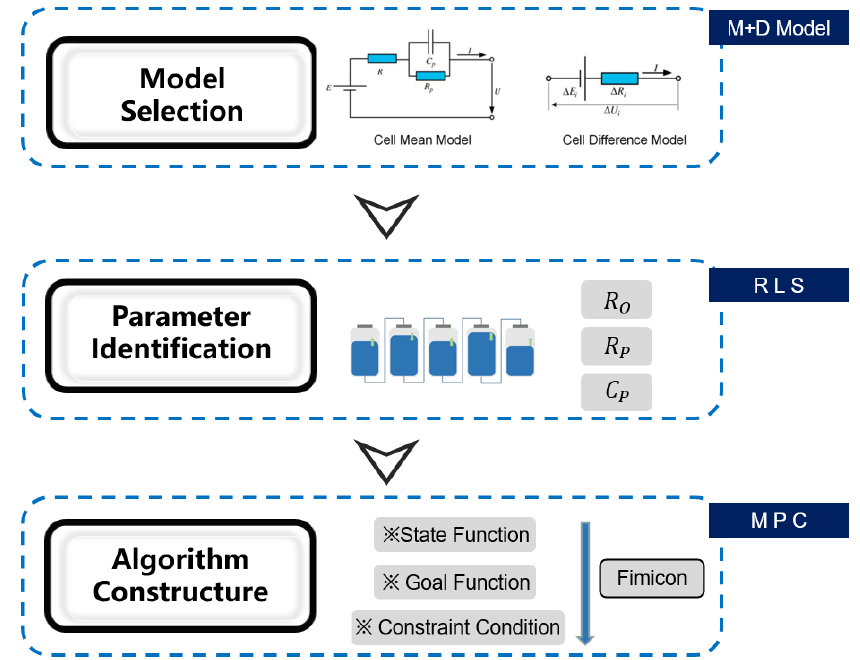
Figure 1. Flow chart of this work.